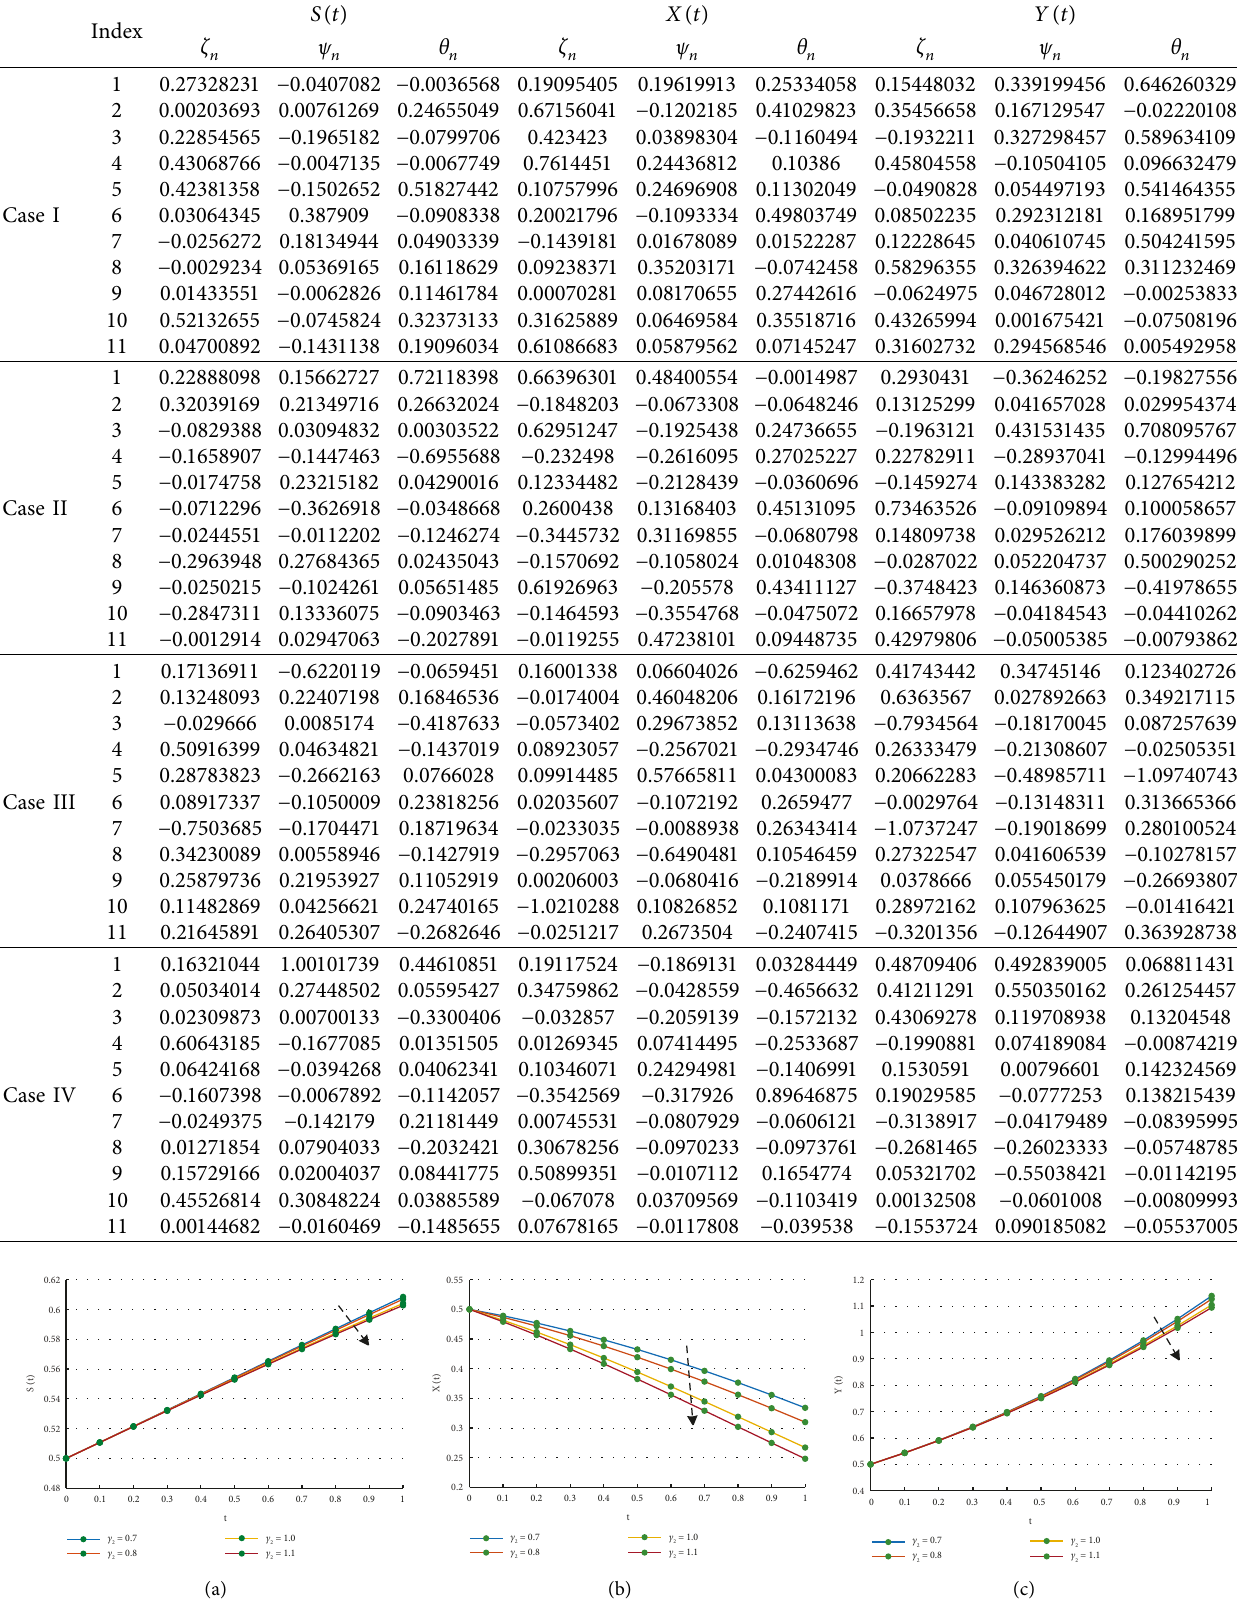
Table 44: Unknown parameters obtained by the LeNN-WOA-NM algorithm for the prey-predator model under the influence of variations in c . 1